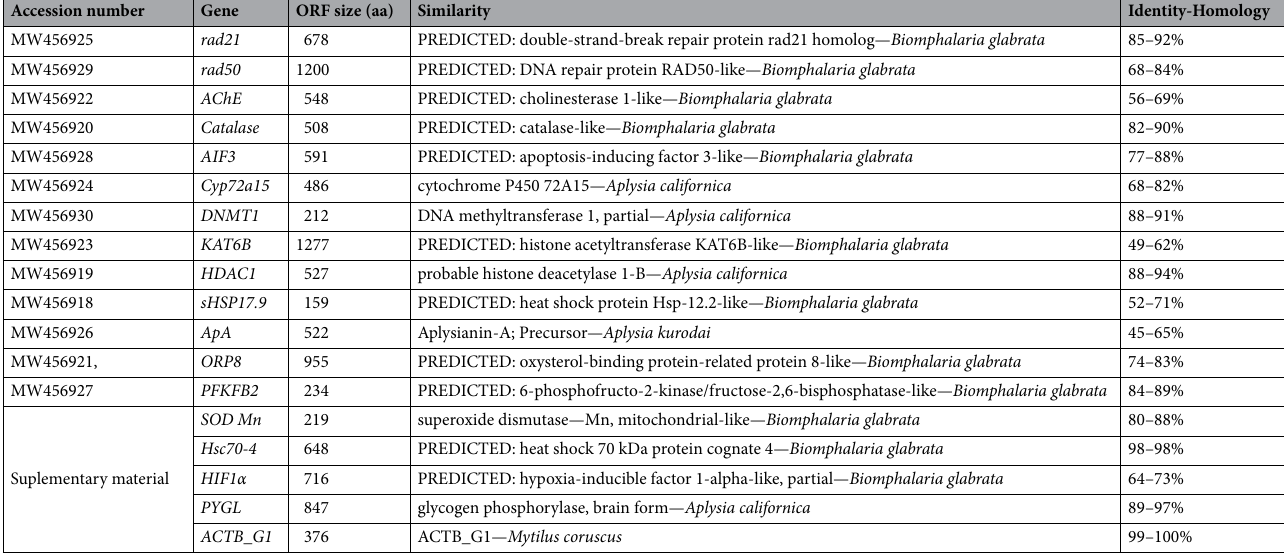
Table 1. Accession numbers and homologies of the newly identified genes in Physella acuta. aa, amino acids; ORF, open reading